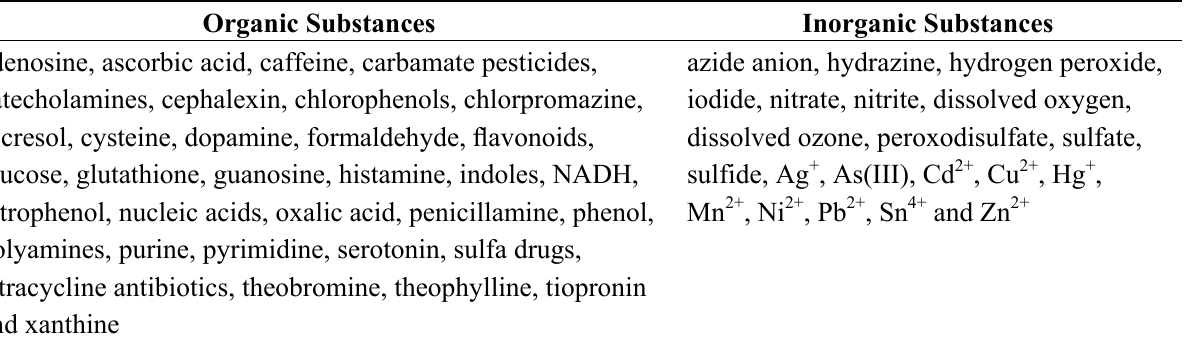
Table 1. Substances electrochemically detected using diamond